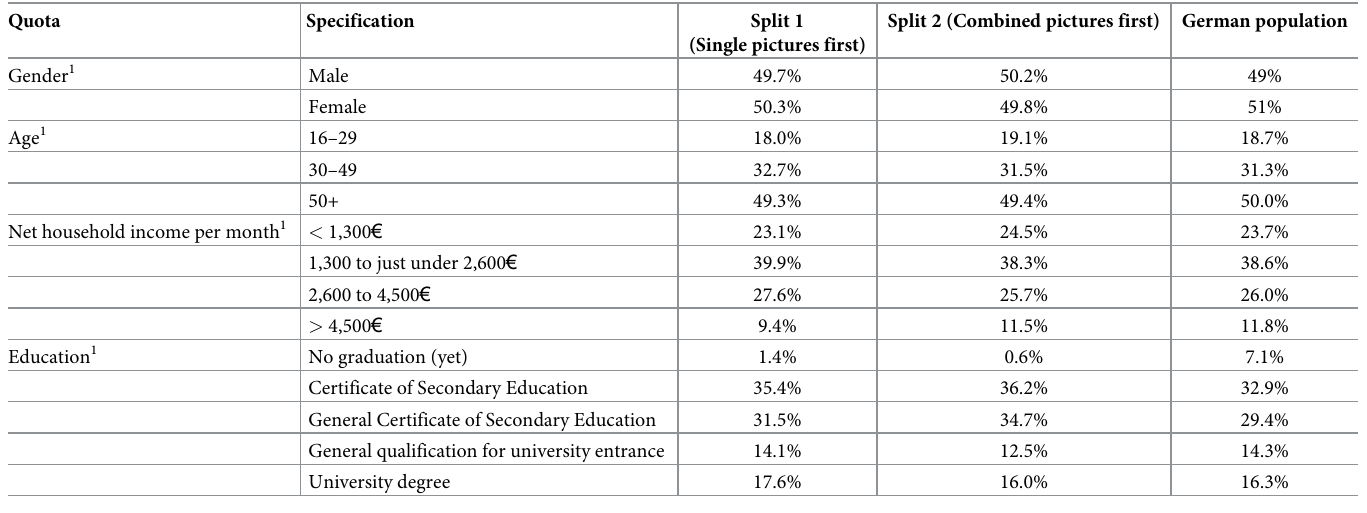
Table 2. Distribution of demographics in the two sample splits (evaluation of single pig and pen pictures first (n = 489) and evaluation of combined pictures first (n = 530)) in comparison to census data from Germany. Quota